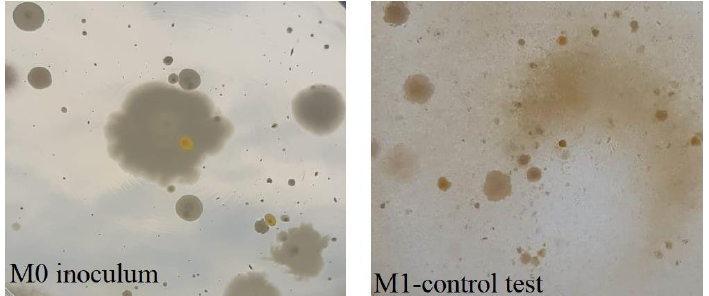
Figure 4. Bacterial inoculum culture ( M0 ) and Non-functionalized chitosan control test culture ( M1 ) (magnification 1×).